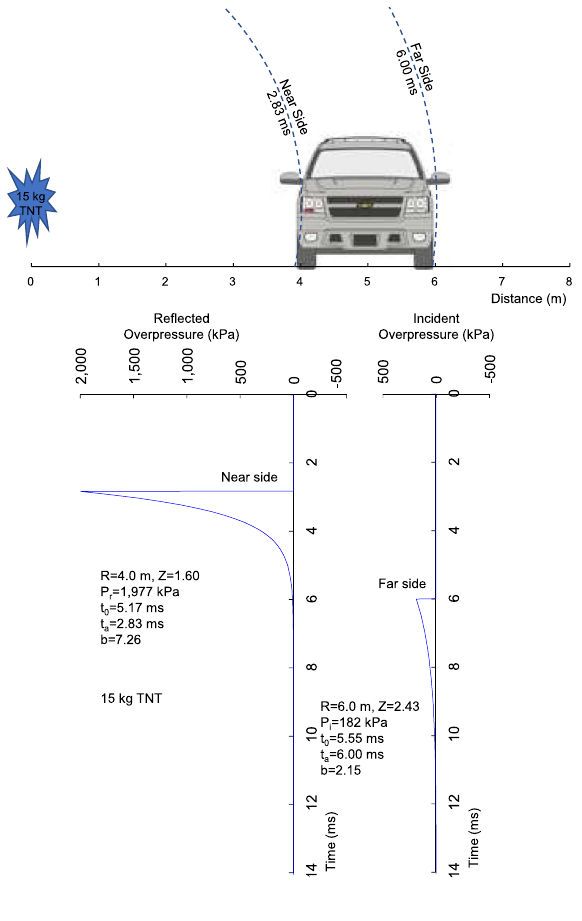
Figure 9. Shock wave loading of an armored passenger-vehicle with 4 m stand-off from 15 kg